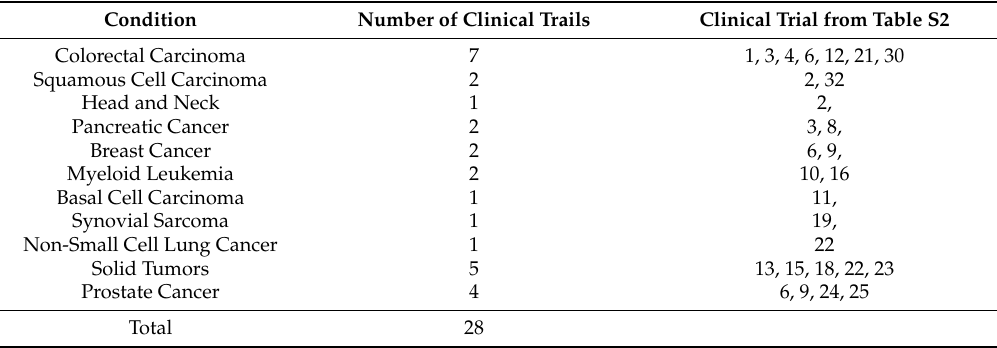
Table 7. Clinical trials involving inhibition of Wnt signaling.